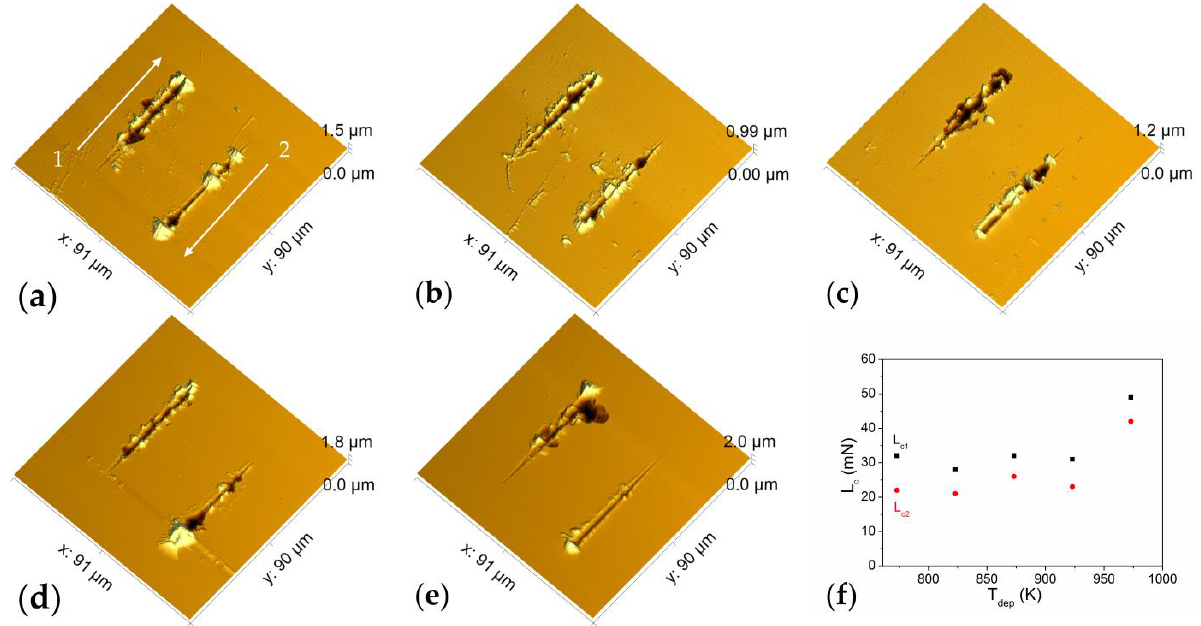
Figure 13. AFM images of scratch traces for LPCVD BC x N y films deposited at varied temperatures: ( a ) 773, ( b ) 823, ( c ) 873, ( d ) 923, and ( e ) 973 K. Indenter orientations: 1—edge-forward and 2—face- forward. ( f ) Temperature dependence of critical loads of LPCVD BC x N y films.